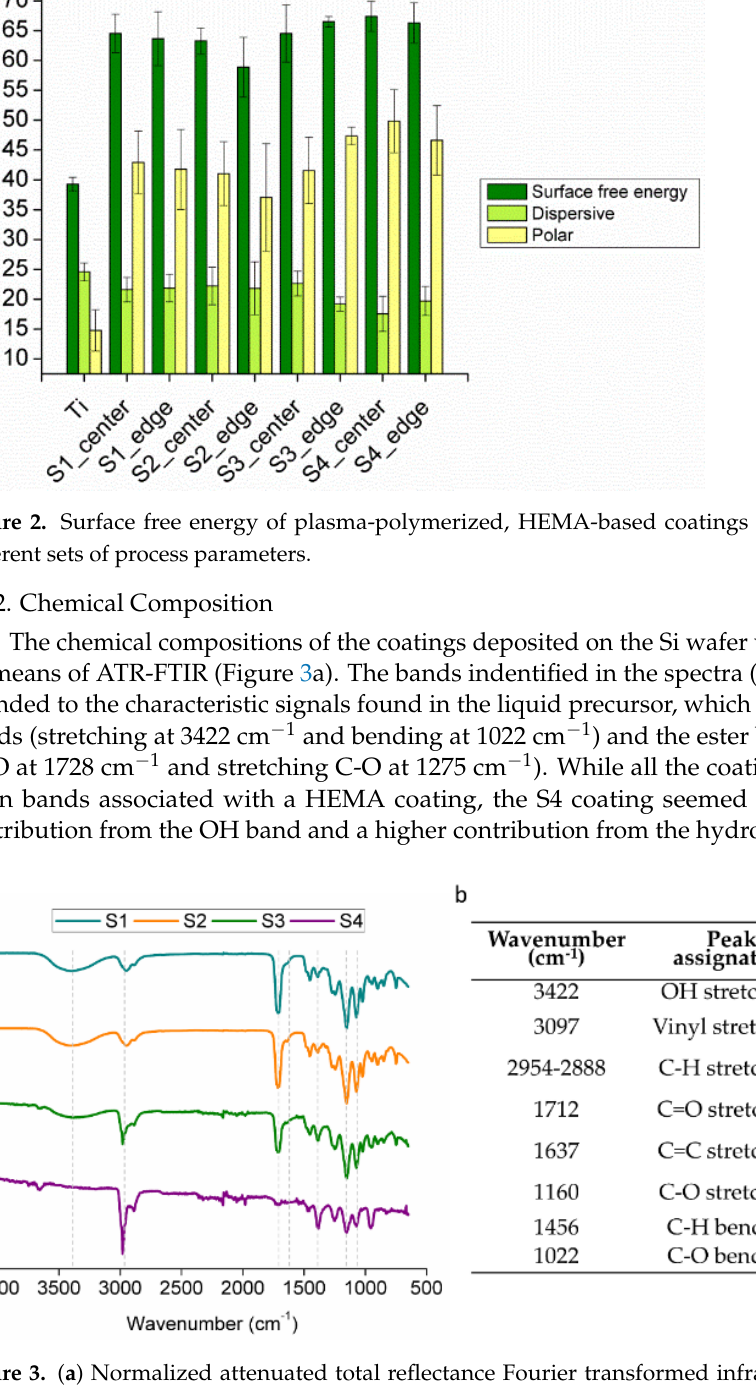
Figure 2. Surface free energy of plasma-polymerized, HEMA-based coatings on Ti samples for different sets of process parameters.